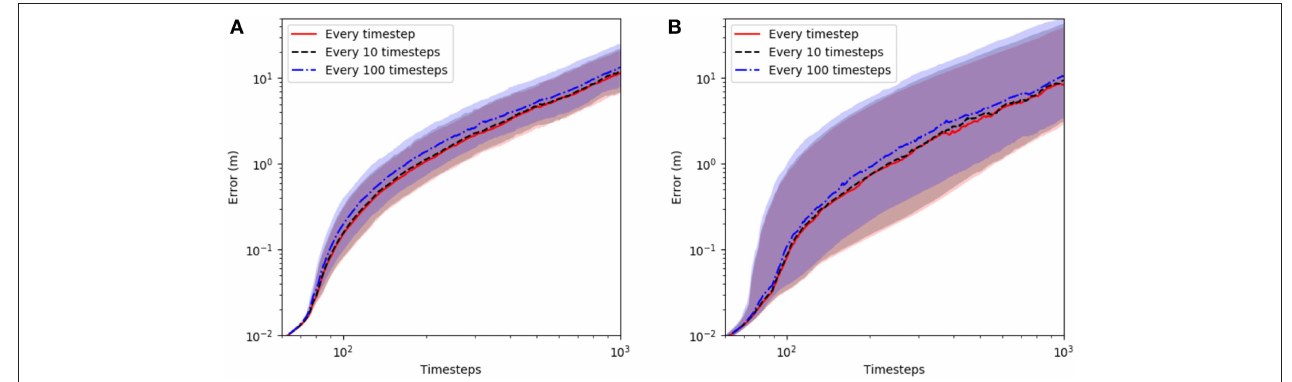
FIGURE 5 | Inter-quartile range of error vs. time when the NCC is performed: every timestep (red), every 10 timesteps (black), and every 100 timesteps (blue). Data for this figure was obtained via two Monte-Carlo simulations which both had 500 realizations wherein the initial conditions: P 1 , M 1 , and V 1 were multiplied (element-wise) by a vector of random elements drawn from uniform distributions between (A) [0.9,1.1], and (B)